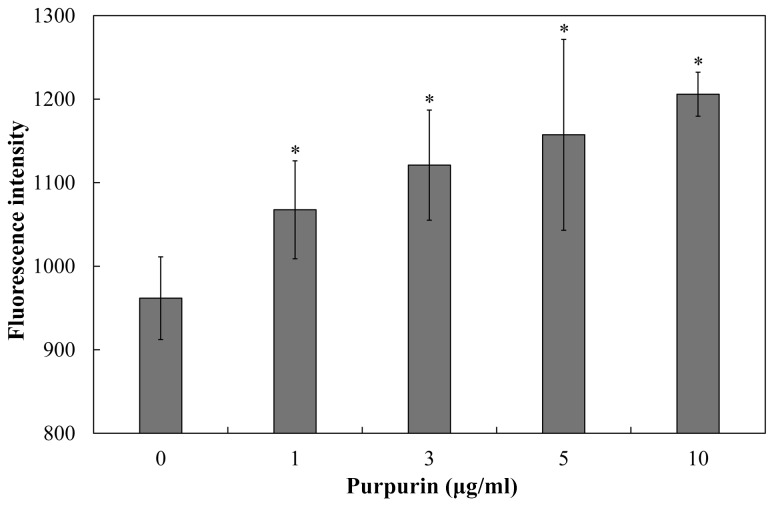
Effect of purpurin on intracellular ROS levels.C. dubliniensis biofilms were treated with different concentrations of purpurin (from 1 µg/ml to 10 µg/ml), and intracellular ROS levels were determined using DCFDA. Fluorescence intensity was measured at 485 nm excitation and 535 nm emission. Results shown were the average of three independent experiments ± SD. *p<0.05 when compared with the untreated controls.